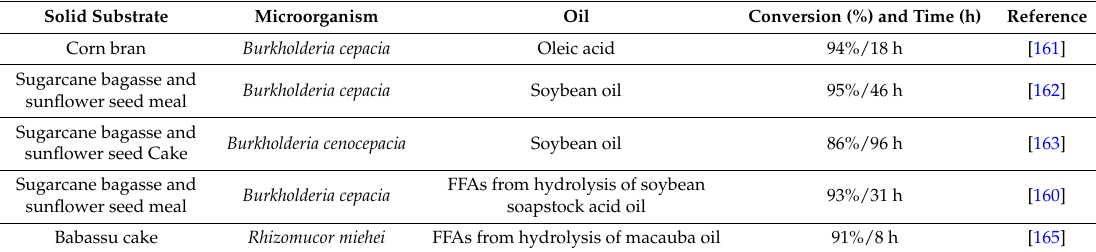
Table 5. Biodiesel production using reactions with fermented solids as